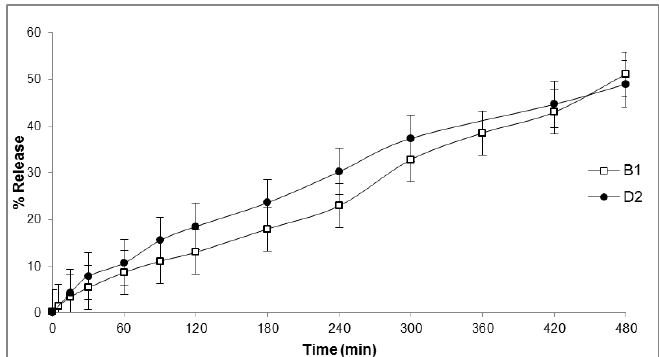
Figure 4. In vitro release of B1 and D2 from oil-in-water cream formulation. Mean ± SEM, n = 2.